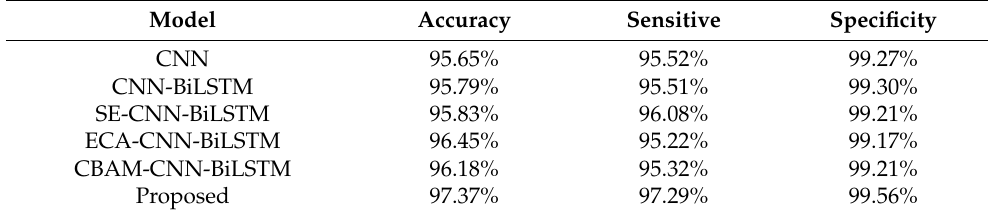
Table 4. Performance comparison of CBAM-IAM-CNN-BiLSTM model with other models.